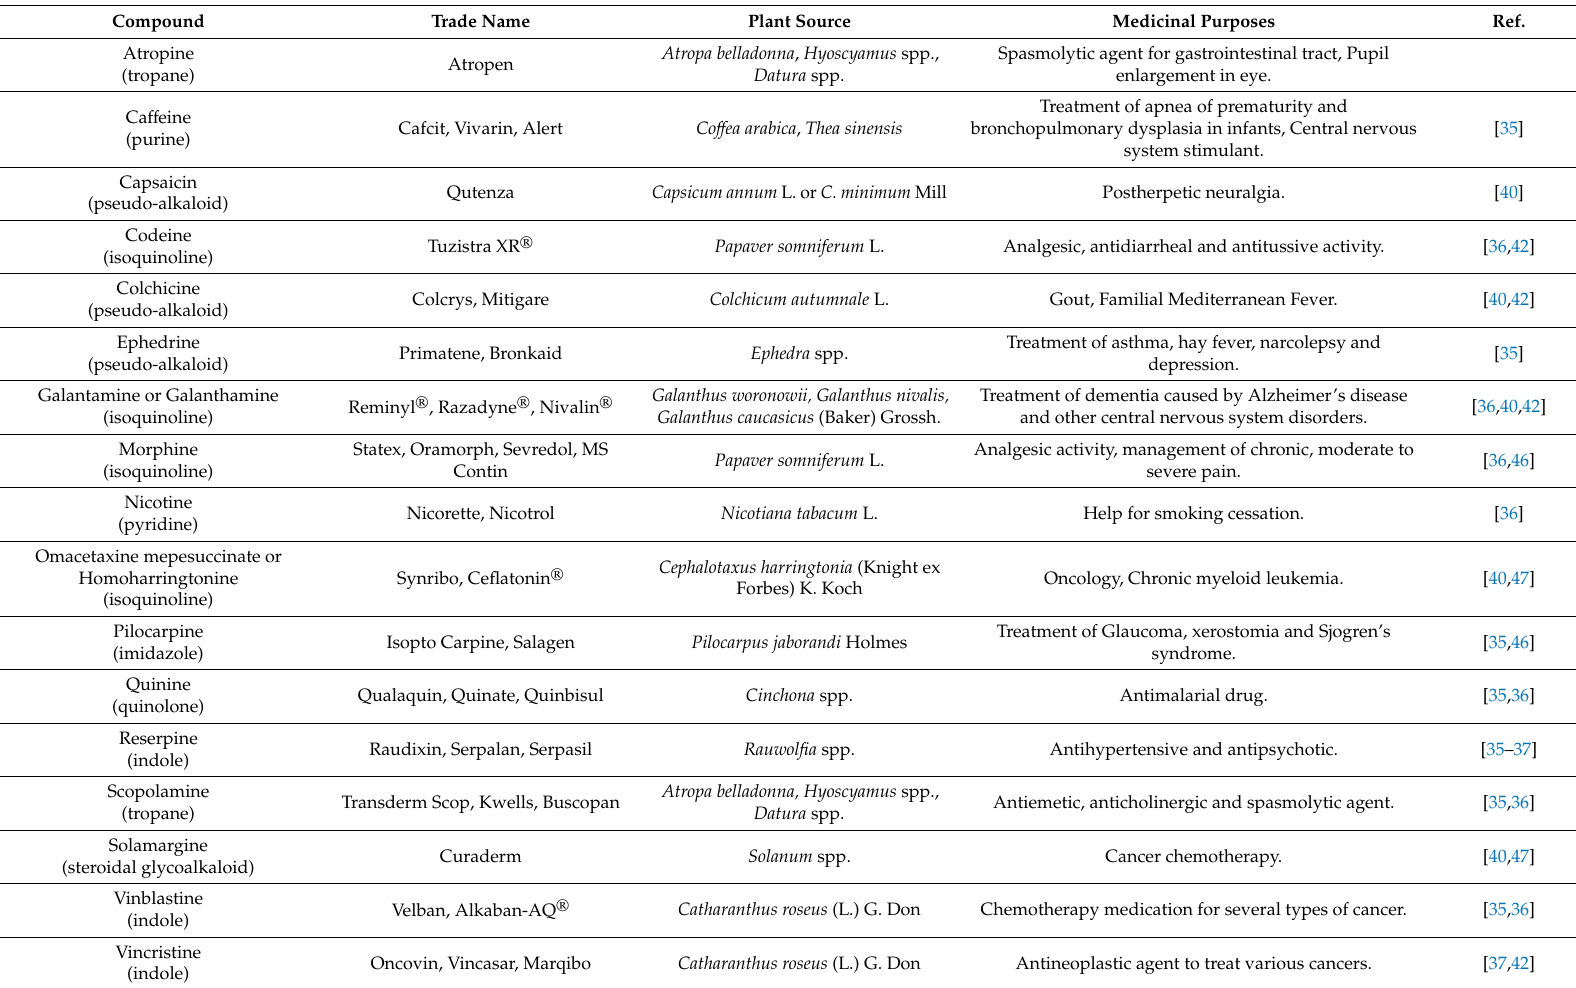
Table 2. Plant-derived alkaloids approved for therapeutic